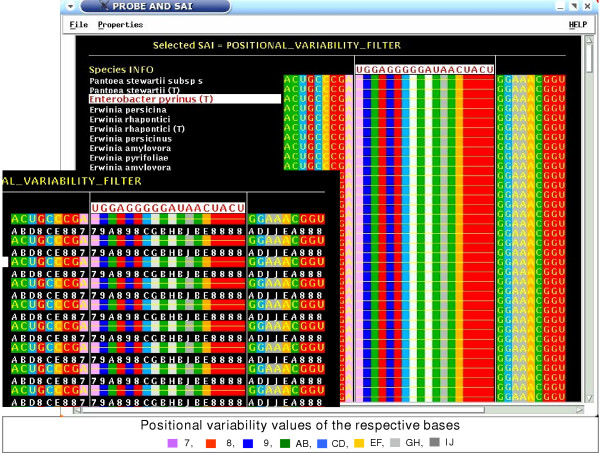
Screenshot showing positional variability filter generated by the respective ARB tool in various background colors (light purple – 7; red – 8; dark blue – 9; green – AB; blue – CD; yellow – EF; light grey – GH; grey – IJ; increasing numbers followed by the alphabetical order of letters indicate increasing degree of sequence conservation).